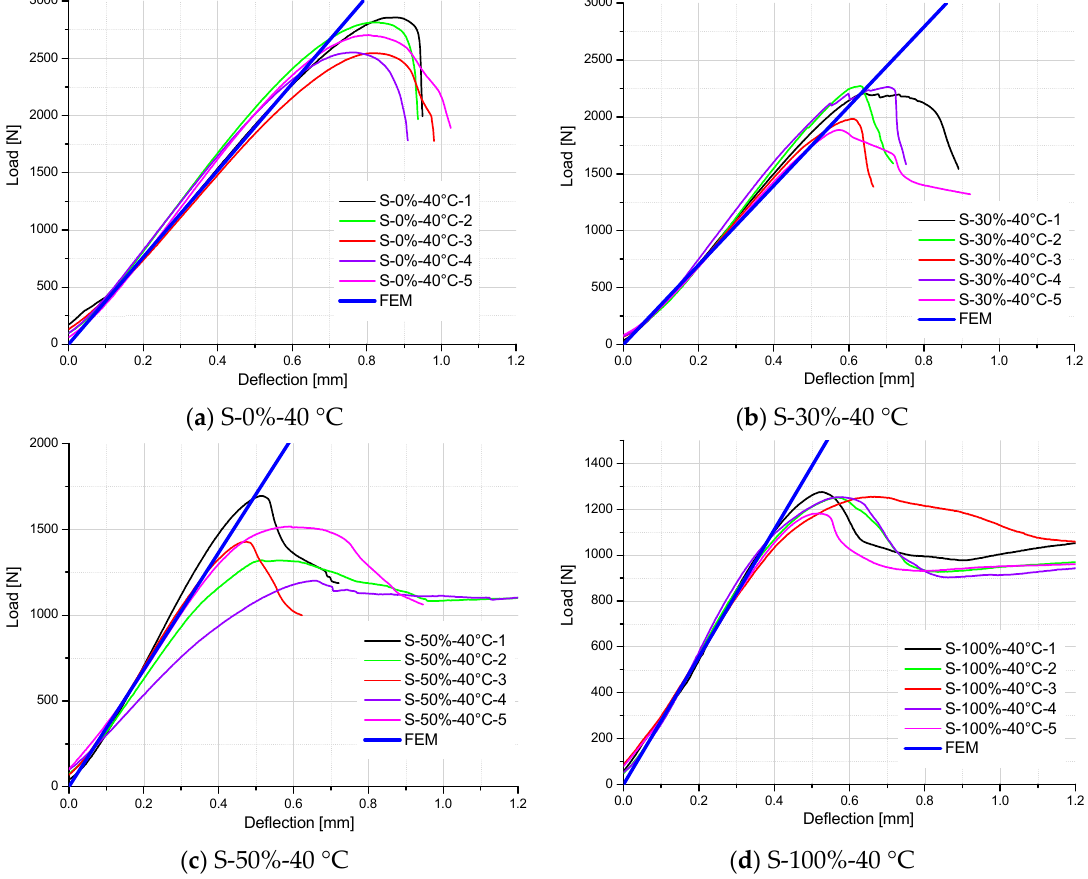
Figure 15. Comparison of load–deflection curves between FE analysis and test results of specimens tested at 40 °C and in the moisture absorption process.